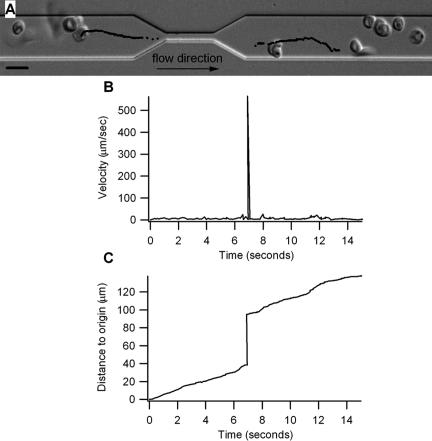
Passage of iRBCs through a Constricted Channel Functionalized with ICAM-1(A) Tracking the movement of an iRBC in a narrowing constriction. Dots mark the spatial position of a typical iRBC every 0.1 s before and after passage through the constriction.(B) Instantaneous velocity of iRBC. Before reaching the constriction, the iRBC moved with the typical jerky, stepwise motion of rolling iRBCs. The velocity spiked each time an iRBC passed through the constriction.(C) Distance from origin of an iRBC over time. The iRBC moved uniform distances over each time step before reaching the constriction. The erythrocyte then moved through the entire distance of the constriction within a single time frame of 0.1 s.Scale bar = 10 μm. See also Video S4.